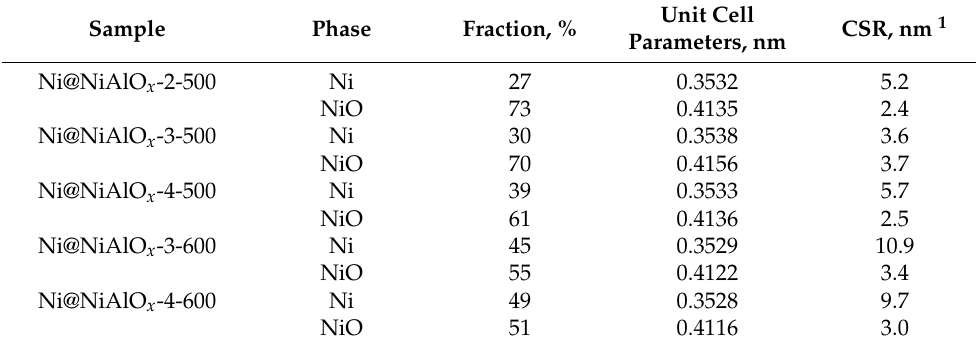
Table 2. Microstructural parameters of the Ni@NiAlO x samples with different atomic ratio of metals and obtained at different reduction temperatures (according to XRD measurements).